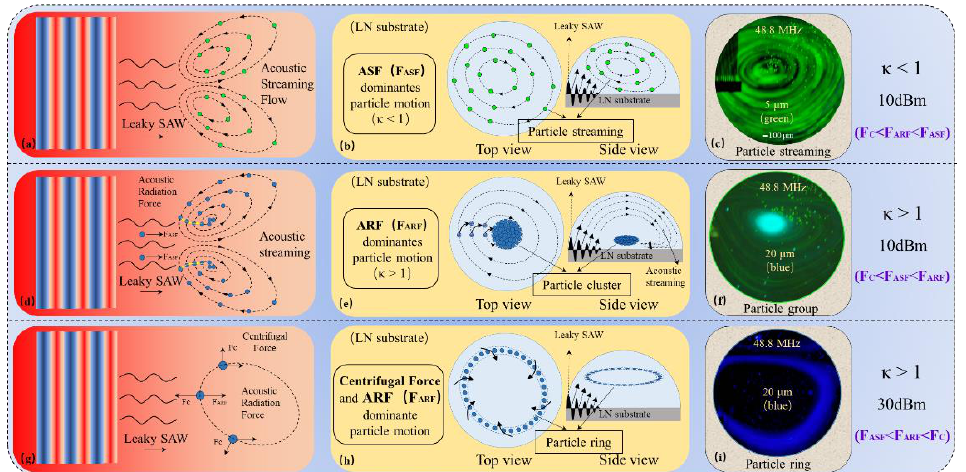
Figure 2. ( a – c ) Demonstrate that when ASF > ARF ( κ < 1, 10 dBm), the drag force caused by ASF dominates the vortex motion of the particles (5μm) along the acoustic vortex streamlines. — Particle Streaming. ( d – f ) Demonstrate that when ASF < ARF ( κ > 1, 10 dBm), the ARF caused by Leaky-SAW dominates the motion of the particles (20 μm) towards the center of the acoustic vortex. — Particle Cluster. ( g – i ) Demonstrate that when ASF < ARF ( κ > 1, 30 dBm), the ARF caused by Leaky-SAW pushes the particles (20 μm) towards the acoustic vortex center, but the enhanced centrifugal force drives the particles out of the center again and against the ARF. The F C and ARF co-dominate the ring motion of the particles around a specific acoustic vortex streamline. — Particle Ring.